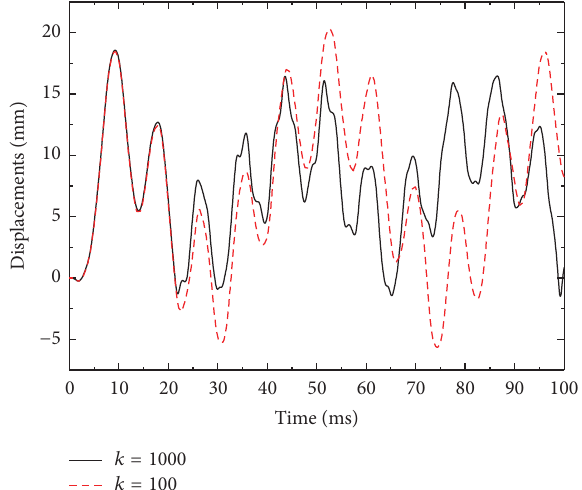
Figure 6: Transverse displacement history at the center point (Node 43) with different spring stiffness.